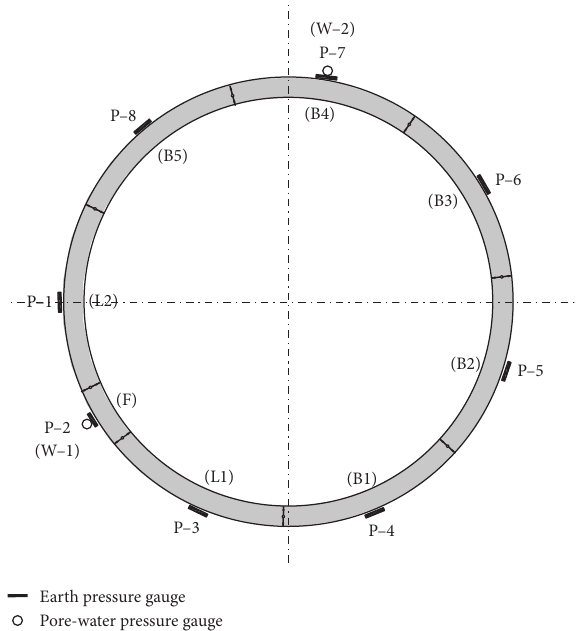
Figure 4: Layout of the earth pressure cells and water gauges in the tunnel lining.